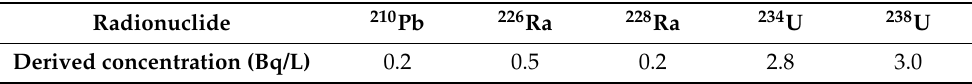
Table 1. Derived concentrations corresponding to the main natural radionuclides present in the studied samples for ID calculation according to Annexe X of RD